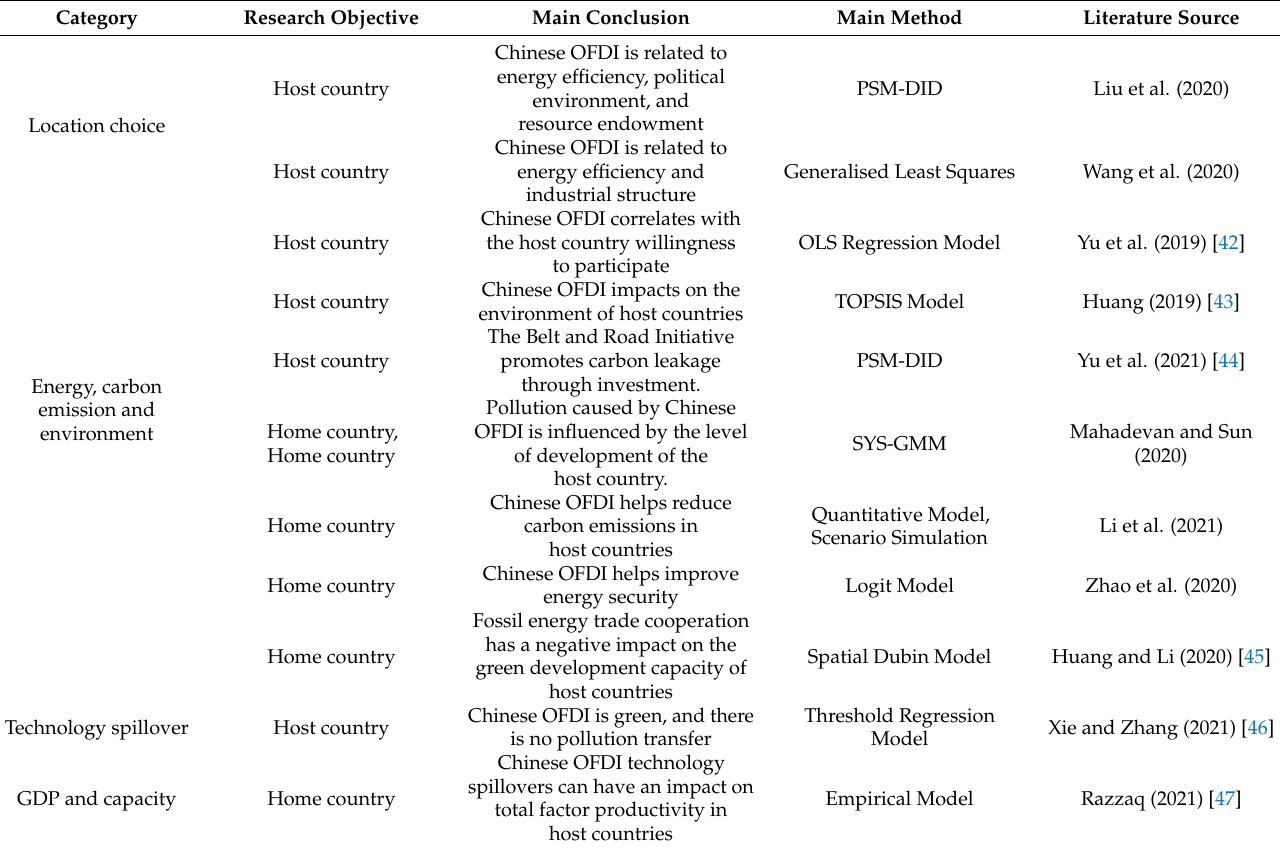
Table 1. The relevance the Belt and Road Initiative to China’s